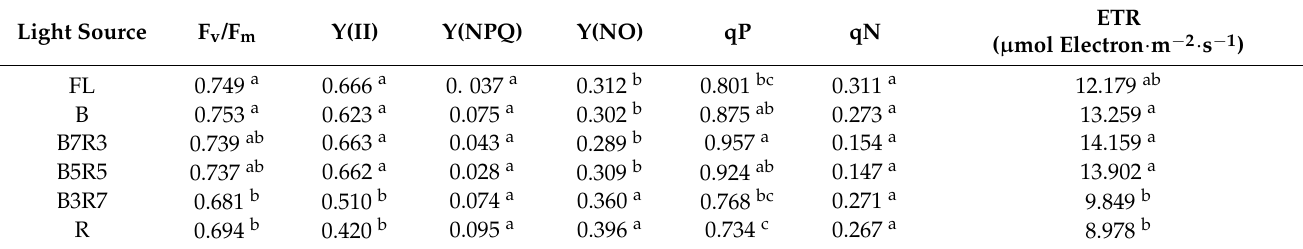
Table 1. The fluorescence parameters in leaves sampled from H. corymbosa plantlets grown in vitro